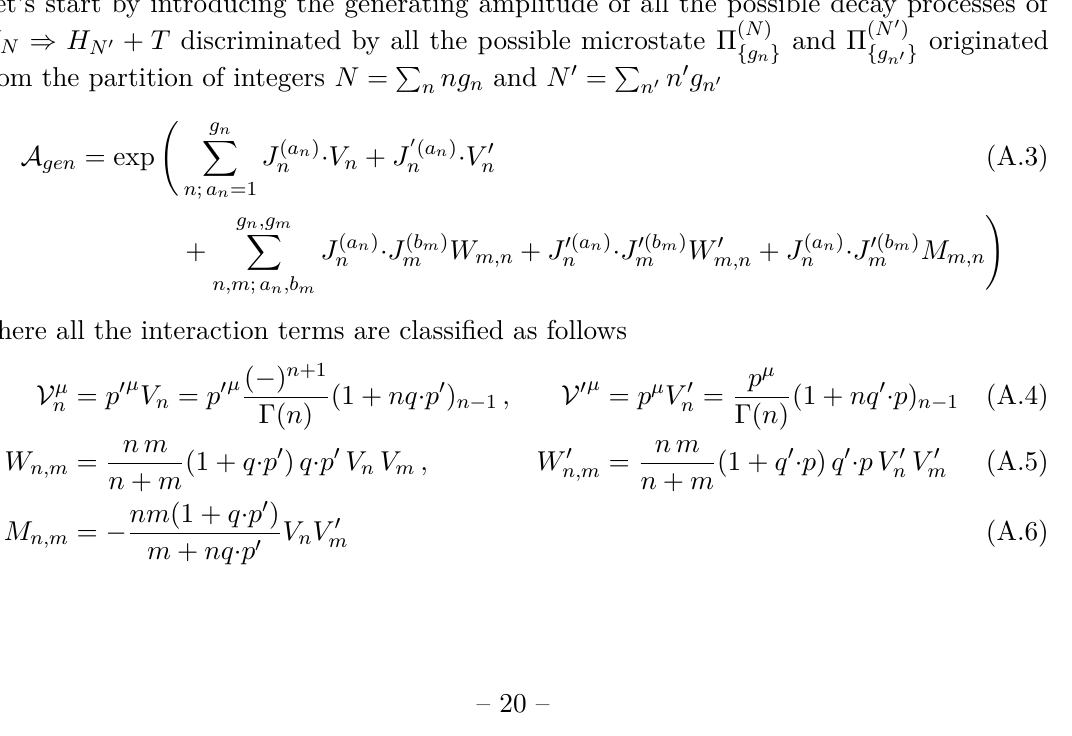
Figure 15 . Picture of the decay amplitude where a representative microstate Π ( N ) Π ( N 0 ) emitting a tachyon T . The DDF structure of the microstates is also depicted below the { g 0 } n 0 decay